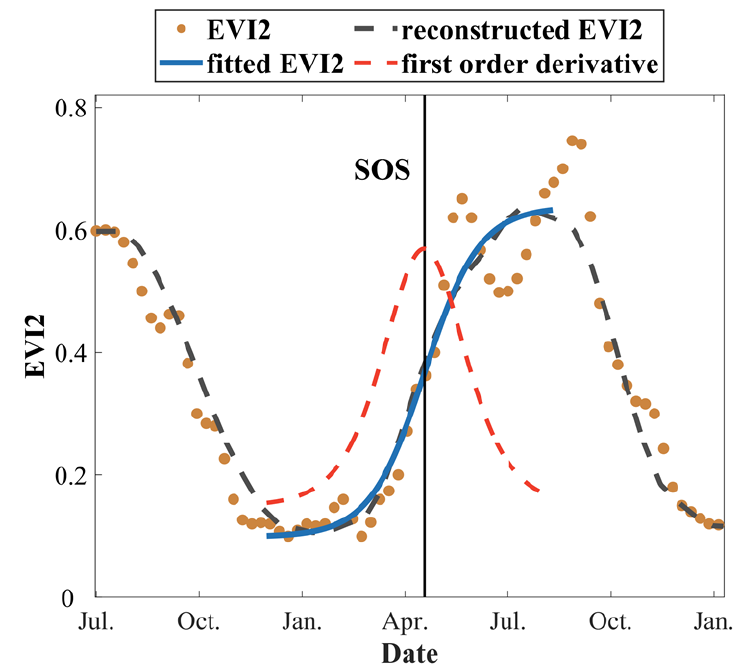
Figure 3. The principle of first-order derivative method to extract the timing of